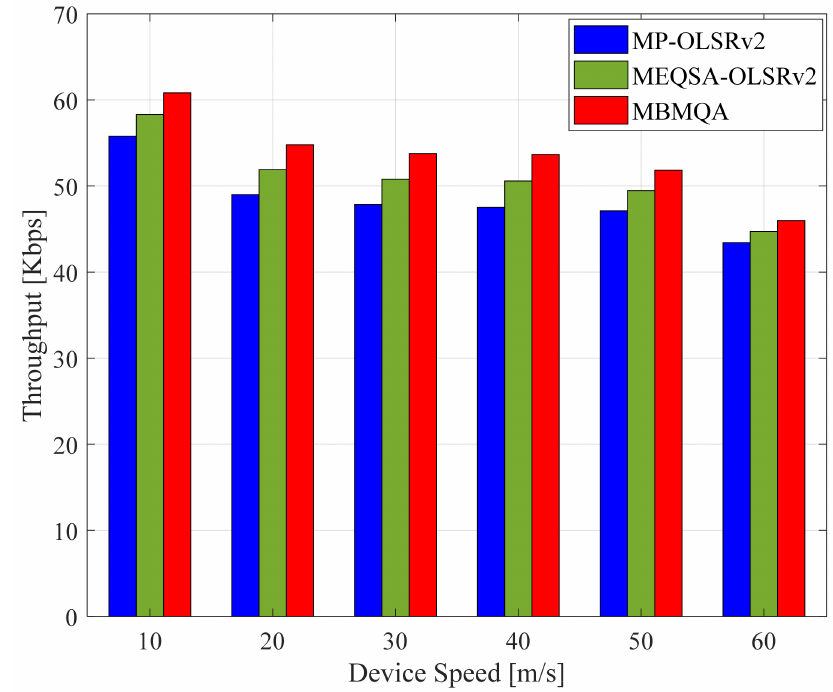
Figure 4. Throughput for various device speeds.